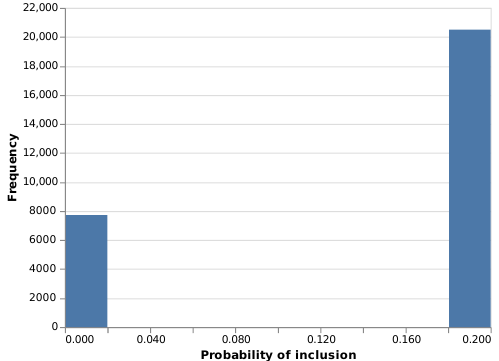
Figure 1. Histogram of population propensities in SC1.